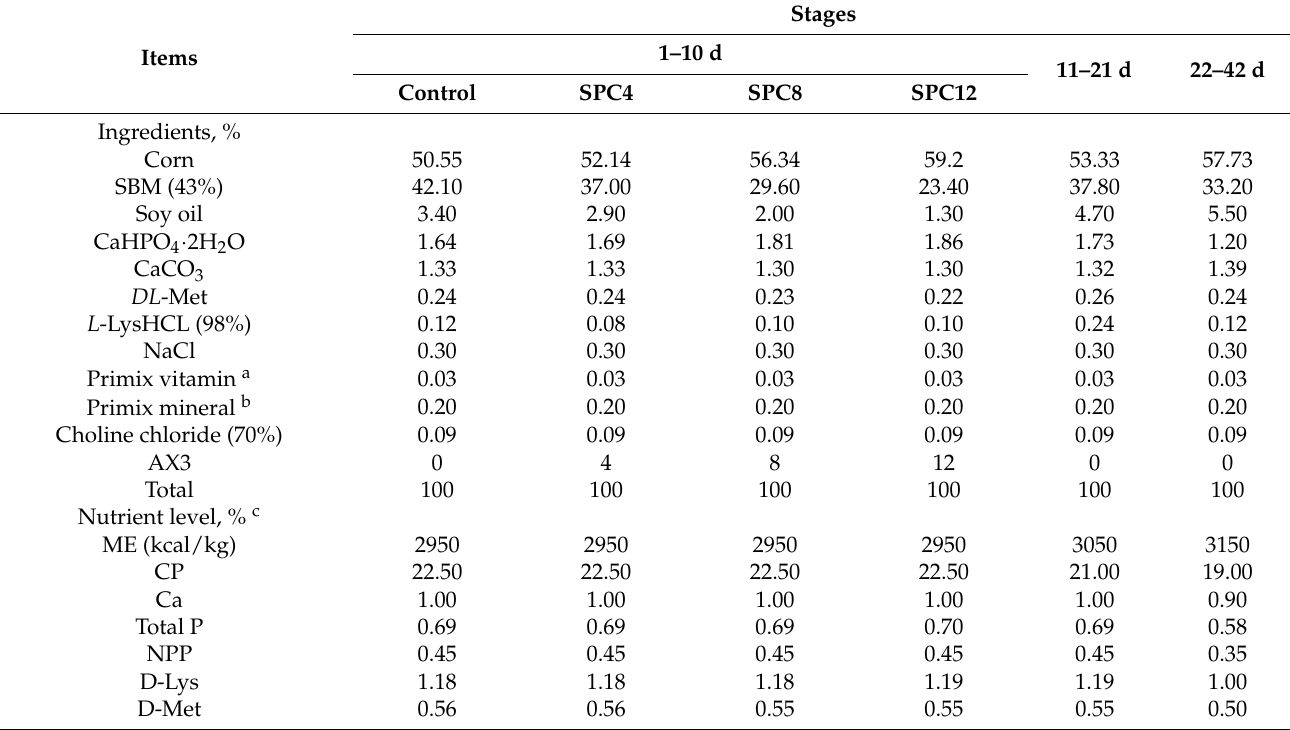
Table 2. Chemical composition of basal diets (as